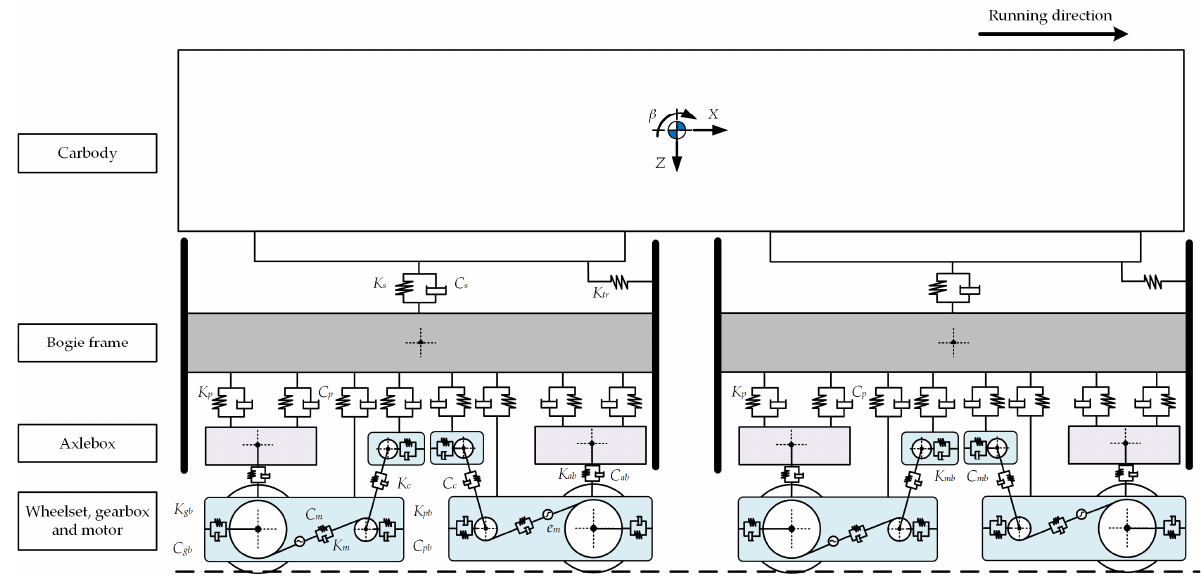
Figure 1. The planar dynamic model of a railway vehicle with the traction transmission system.